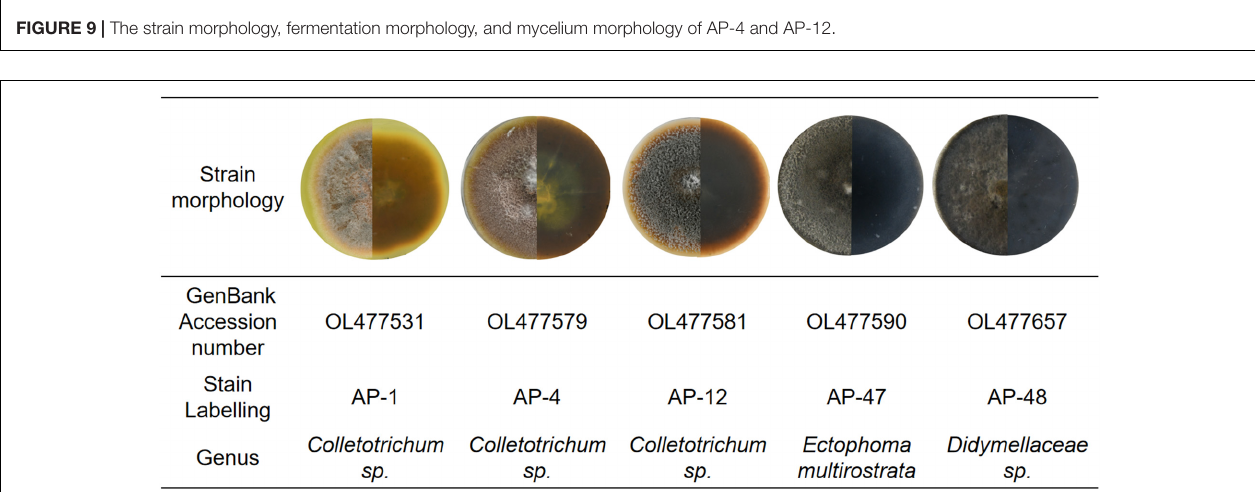
FIGURE 10 | Basic information of AP-1, AP-4, AP-12, AP-47, and AP-48 and their first-generation mycelial